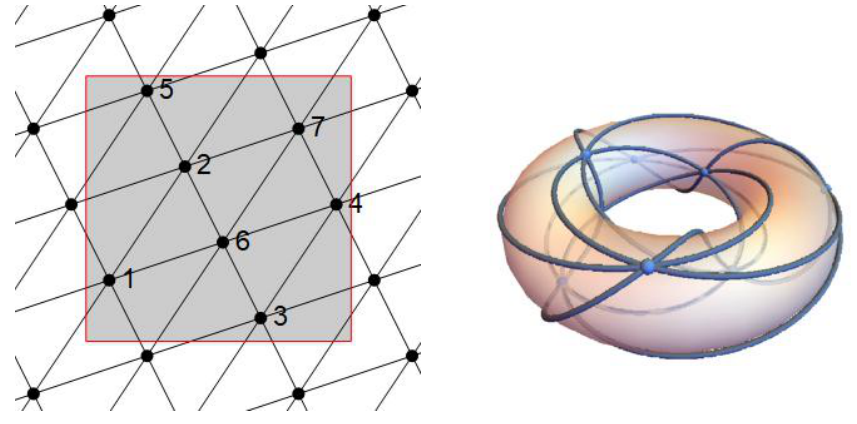
Figure 5. The drawings of K 7 on ( R /2 π Z ) 2 and R 3 .